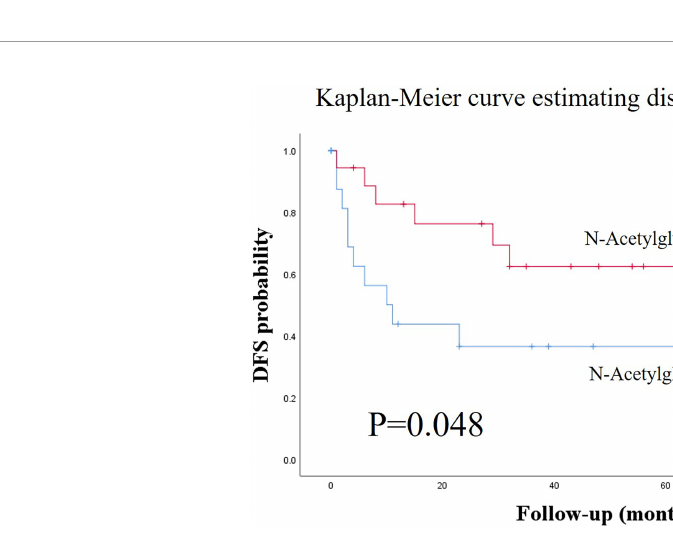
FIGURE 2 | Kaplan-Meier survival curves for estimating overall survival (OS) based on the de fi nitive variable, which is adopted in the Cox hazard model in the validation group. Patients with higher salivary 3-methylhistidine levels (> median) had signi fi cantly lower OS rates than those with lower salivary 3-methylhistidine levels (< median) in the test group (p = 0.020). OS, overall survival.